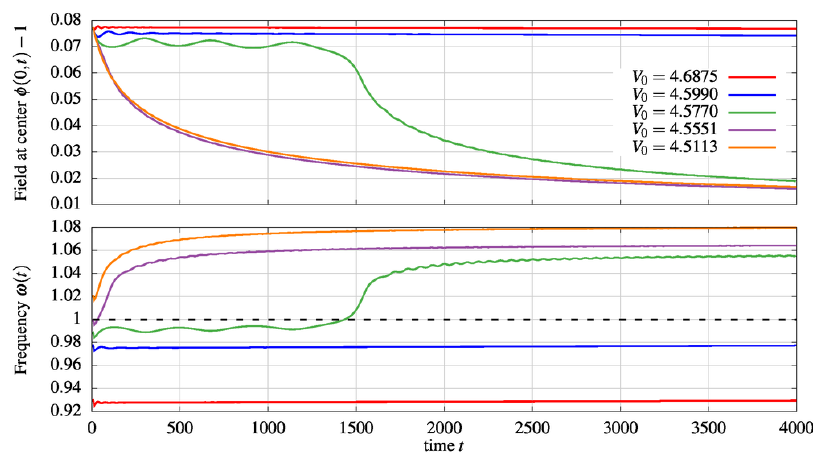
Figure 15 . Time evolution of the oscillational mode with amplitude A 0 = 0 : 08 potential width b = 1 and various depths just below the value when the second harmonics is hidden in the linear approximation. Upper plot shows the maxima of (cid:12)eld value at x = 0, the bottom plot shows the measured frequency ! ( t ) = 2 (cid:25)=T , where T is a time between two subsequent maxima. The red and blue curve represent slow relaxation through the third harmonic, the green curve shows the transition between two di(cid:11)erent types of decay, which appear due to the nonlinearities related with relatively large values of the amplitude, the purple and orange curves correspond to the radiative decay through the propagation of the second